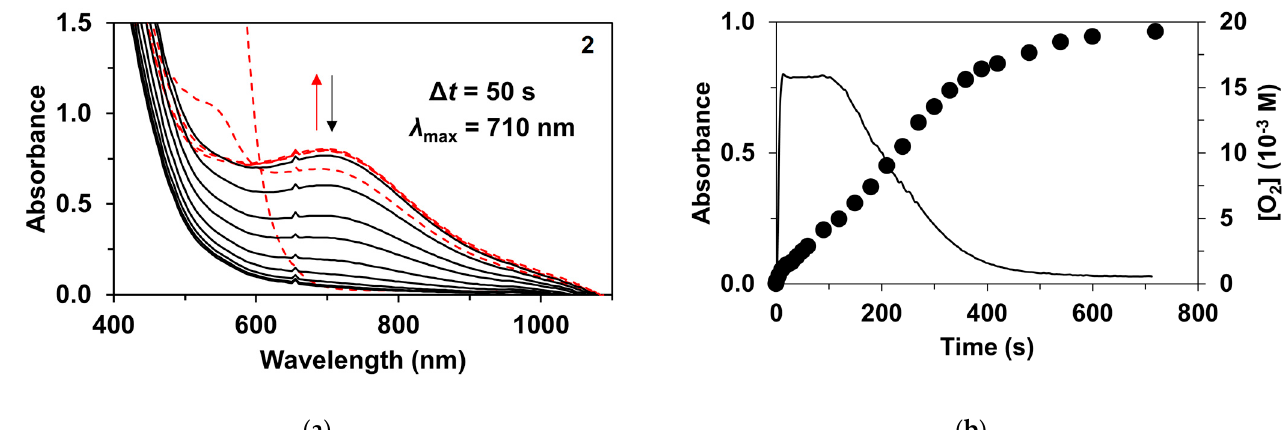
Figure 9. ( a ) UV–Vis spectral changes of 2 P during the catalytic disproportionation reaction of H 2 O 2 . ( b ) Time course of the formation and decay of 2 P during the catalytic disproportionation reaction of H 2 O 2 and the parallel formation of dioxygen monitored by UV–Vis spectroscopy at 710 nm and by volumetrically determined amounts of evolved dioxygen. [ 2 ] 0 = 1.0 × 10 − 3 M, [H 2 O 2 ] 0 = 0.3 M, T = 298 K in MeCN.